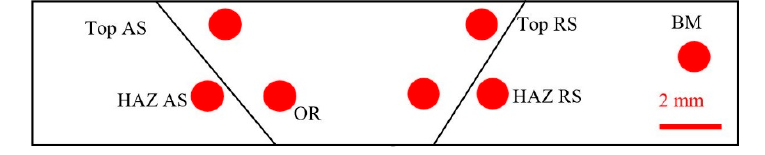
Figure 12. Shear punch test locations in sample T4.